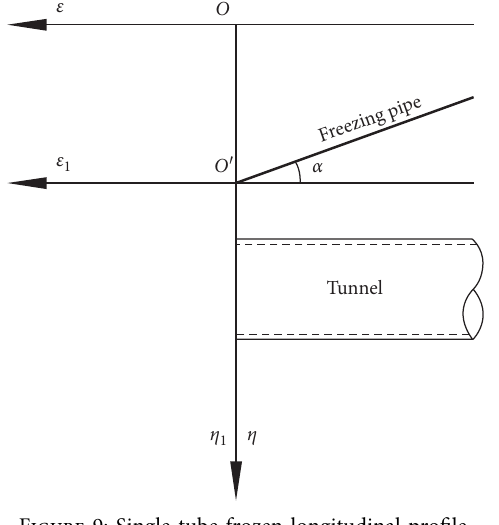
Figure 9: Single-tube frozen longitudinal profile.